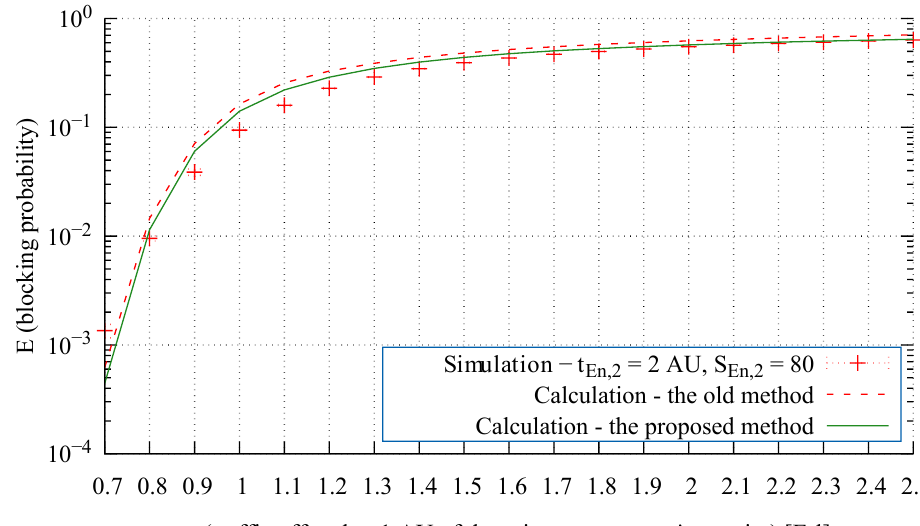
Figure 14. Blocking probability of the Engset traffic class t En,2 = 2 in the secondary resources in System